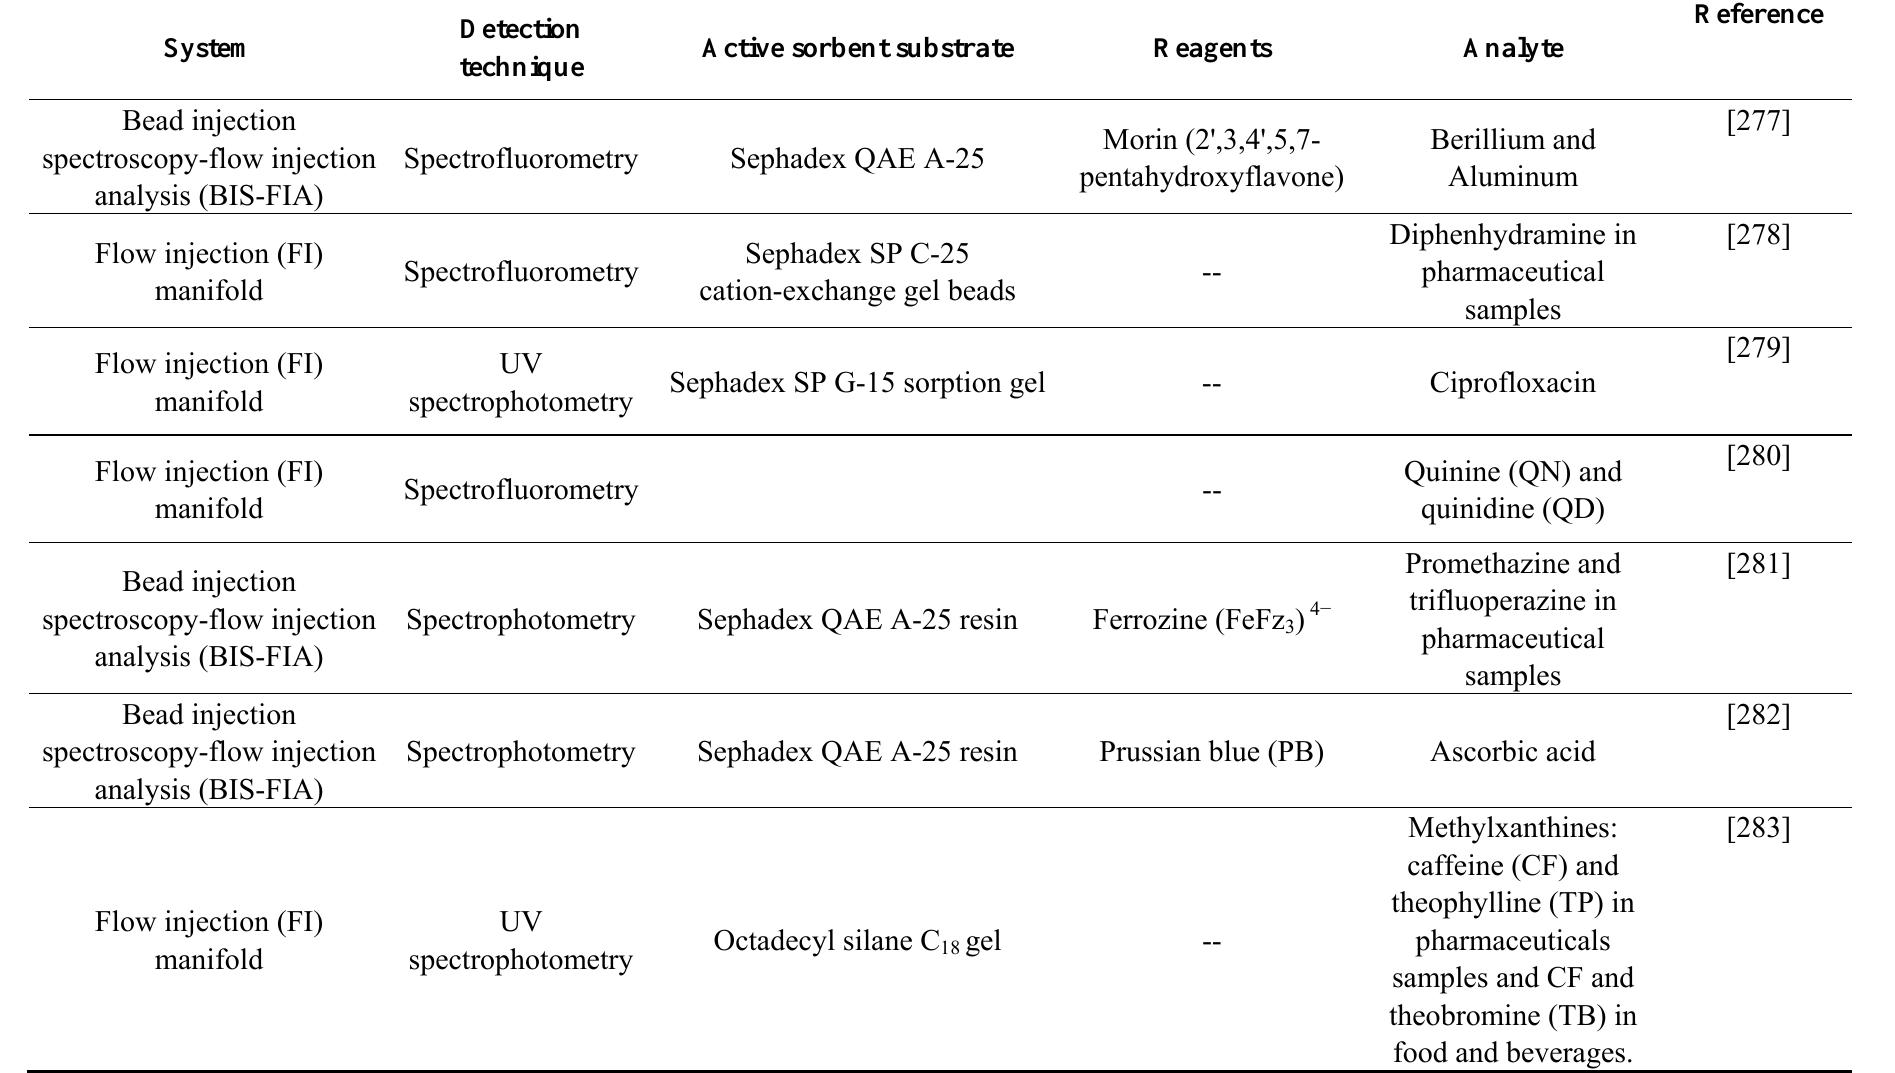
Table 4. Selective f low-through fluorescence-based